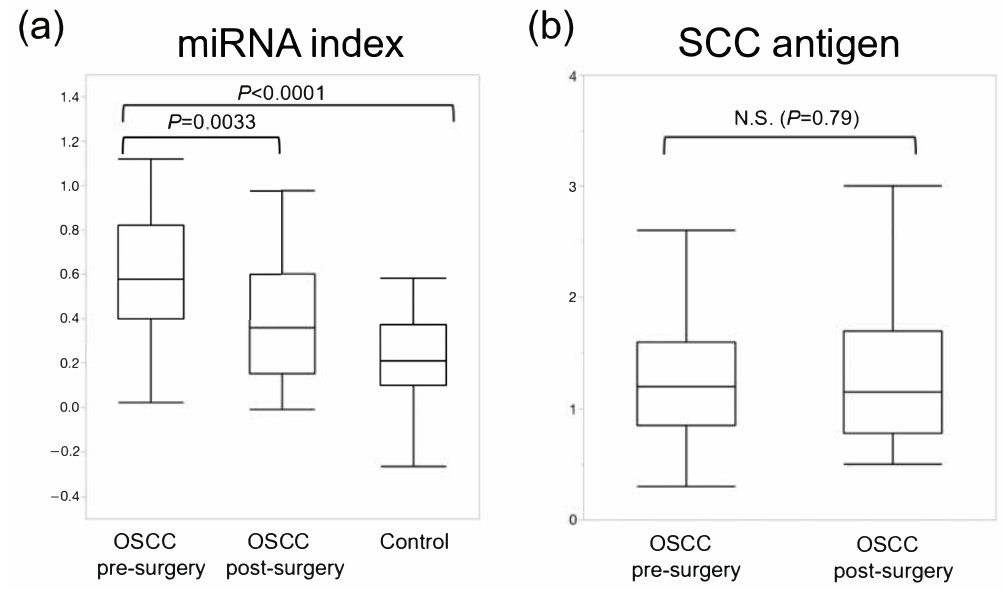
Figure 6. The diagnostic performance of the combination of miRNAs compared with that of a conventional serum tumor marker. ( a ) The miRNA index level of the OSCC group (OSCC pre-surgery) was significantly higher than that of the post-surgery OSCC group and the control group ( p < 0.0001 and p = 0.0033, respectively, Wilcoxon test). ( b ) The serum squamous cell carcinoma (SCC) antigen level showed no significant difference between pre-surgery and post-surgery OSCC groups ( p = 0.79, Wilcoxon test). Table 3. Diagnostic performance of the miRNA index and serum squamous cell carcinoma (SCC) antigen among pre-surgery and post-surgery oral squamous cell carcinoma (OSCC) groups and the control group.